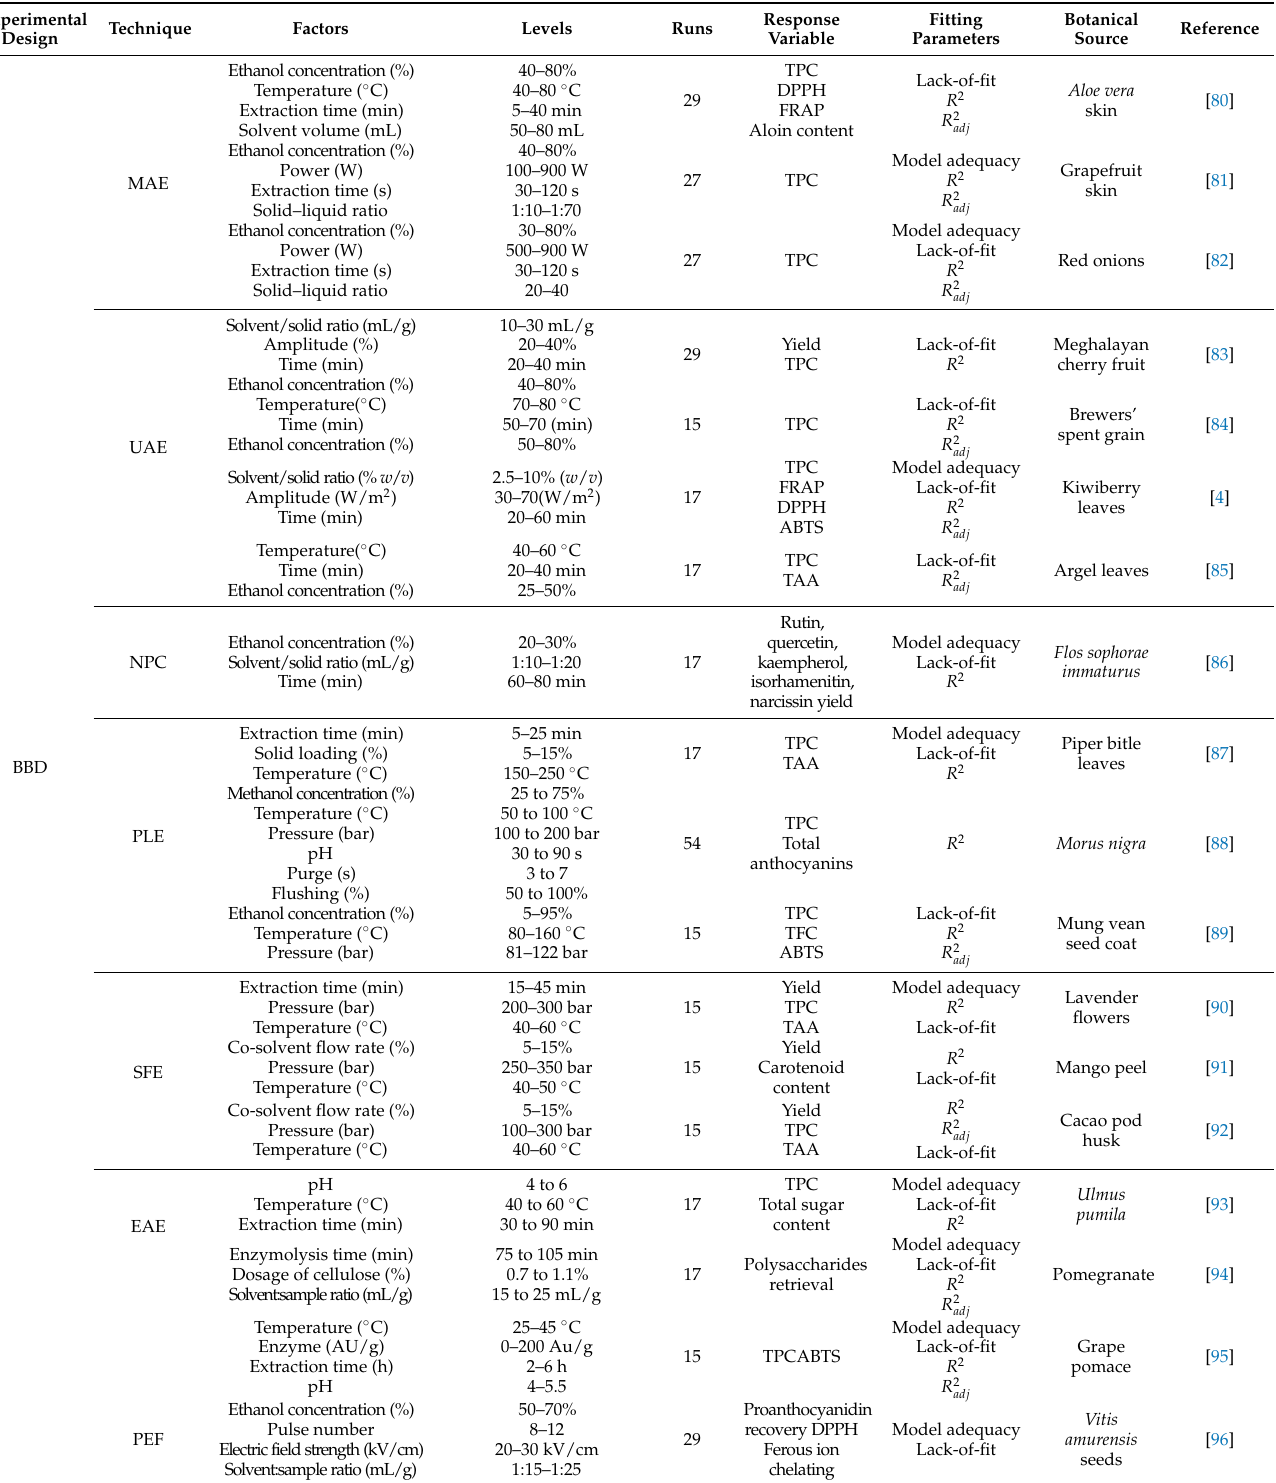
Model adequacy Lack-of-fit